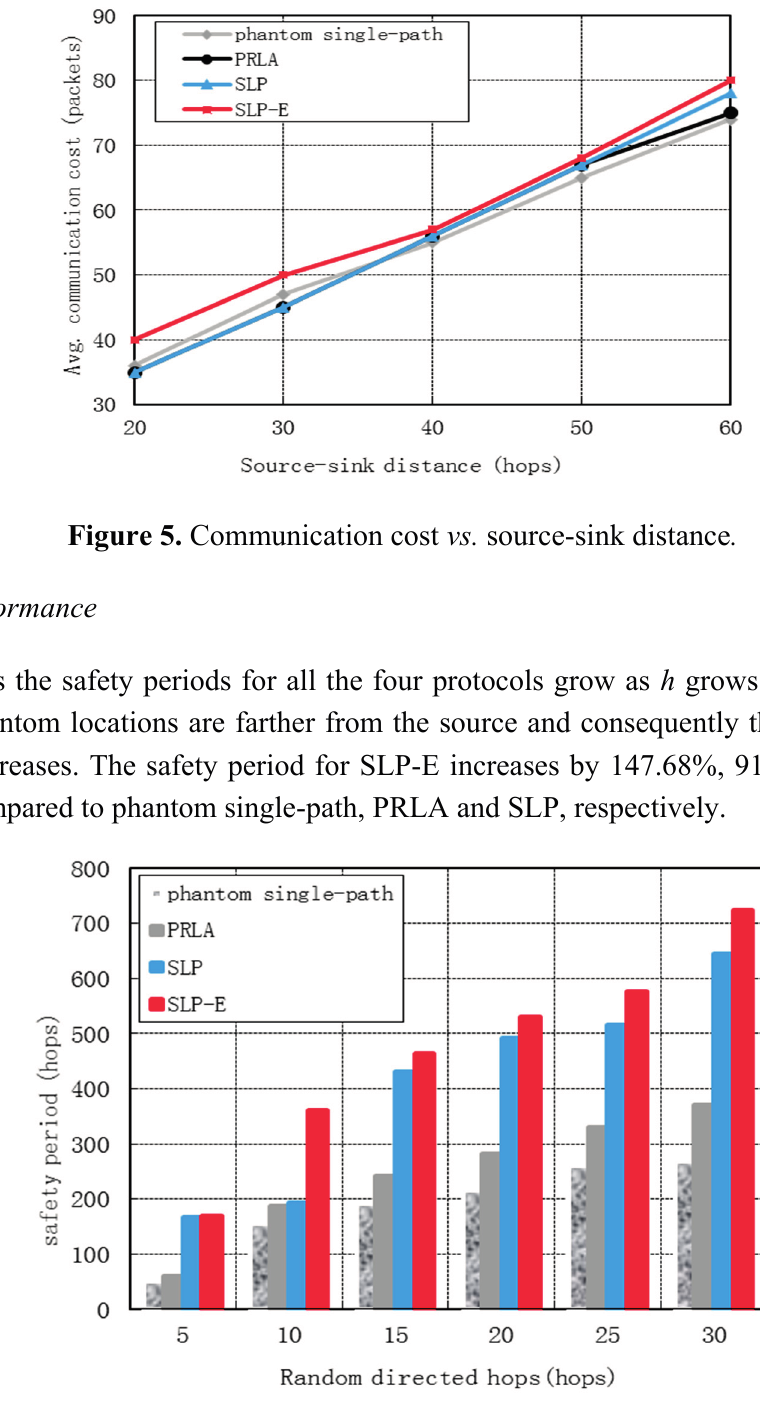
Figure 6. Safety period vs. random directed hops